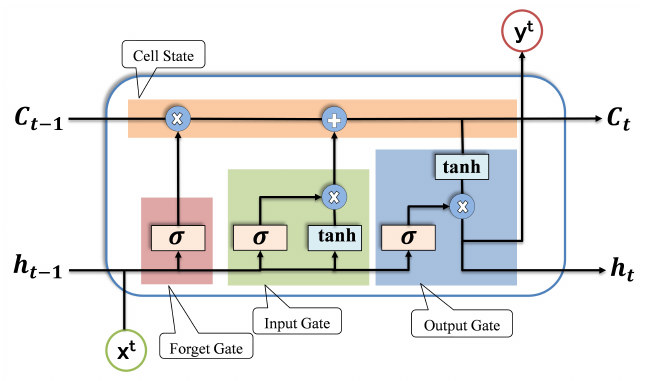
Figure 1. Internal structure of LSTM